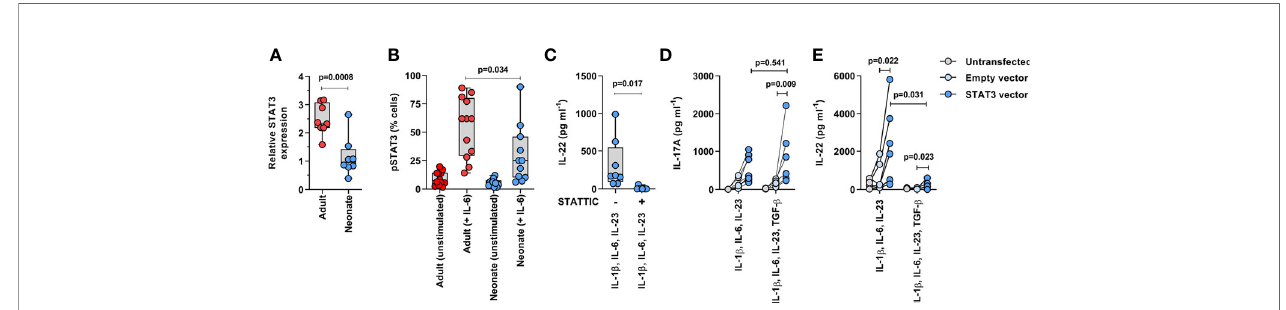
FIGURE 5 | Reduced STAT3 expression limits neonatal Th17 cell differentiation. (A) qPCR con fi rmation of STAT3 gene expression in 8 neonatal and 8 adults naïve CD4 T cell samples (normalized on GAPDH; p value by unpaired T test); (B) STAT3 phosphorylation (intracellular fl ow cytometry) measured in neonatal and adult naïve CD4 T cells (gated on CD3 + CD4 + CD45RA + cells) after 15 minutes stimulation with IL-6 (100 ngml − 1 ). Data are combined from 6 donors per age group in 2 separate experiments (p value by unpaired T test); (C) IL-22 production in neonatal T cells after 3 days of stimulation (anti-CD3/CD28 beads) in the presence of IL- 1 b , IL-6 and IL-23, with or without STAT3 inhibition (Stattic, 10 m M); (D) IL-17 and (E) IL-22 production (normalized to %GFP+ live cells) in non-transfected, control (empty) GFP vector- and STAT3/GFP vector-transfected neonatal naïve CD4 T cells stimulated for 3 days (anti-CD3/CD28 beads) with IL-1 b , IL-6 and IL-23 ± TGF- b ; data are from 7 independent experiments, with lines connecting cells from the same blood donations; p value by paired t-test or